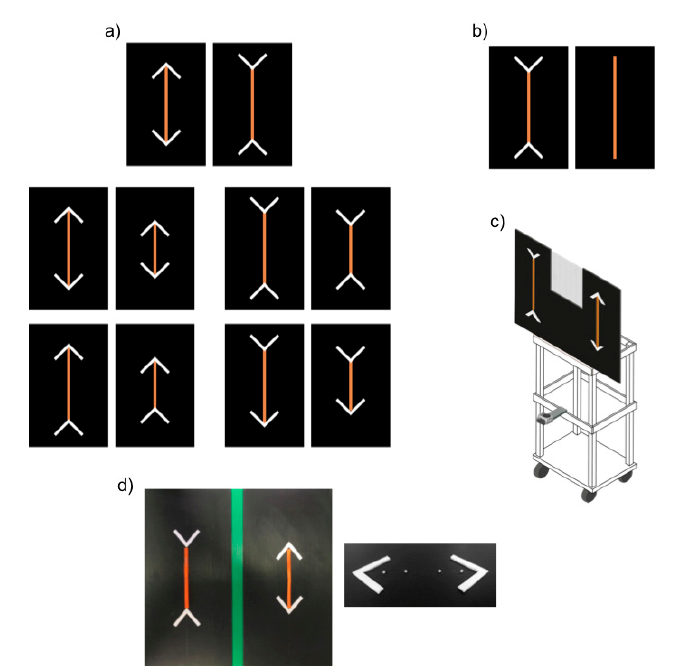
Figure 1. Stimuli used in the study. ( a ) The Müller-Lyer illusion and the four different configuration types used in the control trials; ( b ) stimuli used in the control test for overall size; ( c ) simulation of the placement of stimuli on the tray; ( d ) picture of the stimuli ( left ); arrowheads and plastic screws used to hold the carrot sticks ( right ).